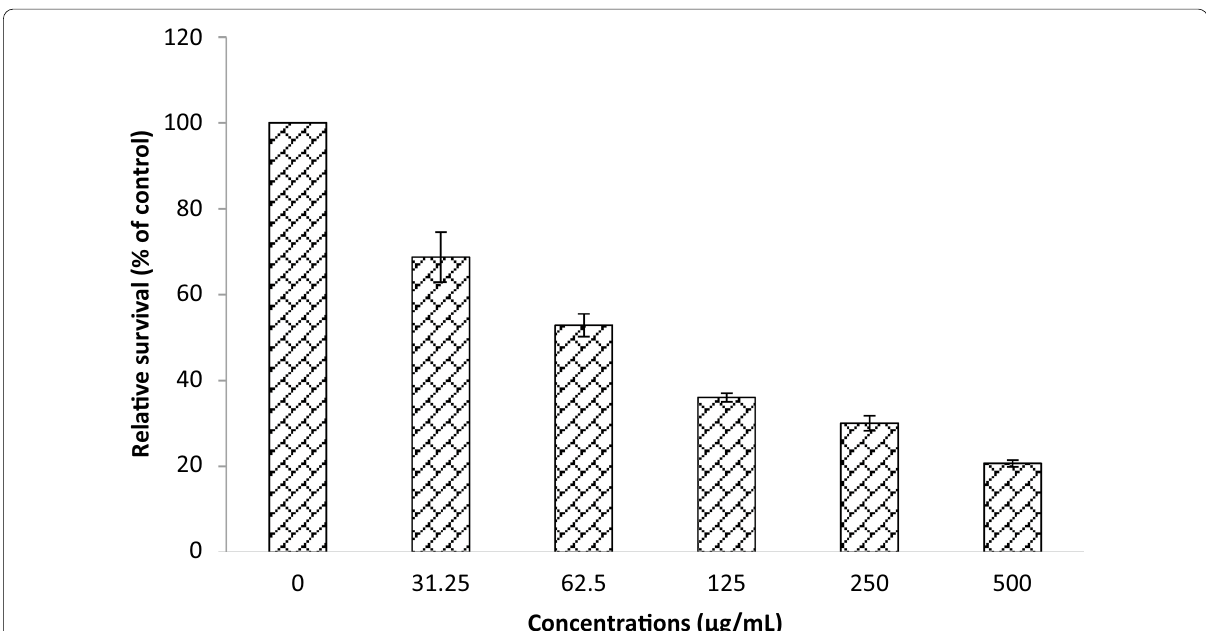
Fig. 5 Effects of CNDCM fractions extracts on the clonogenic activity of human breast cancer cells. The relative survival cells of clonogenicity assay result when treated with various concentrations of CNCDM after 72 h. All data expressed as mean